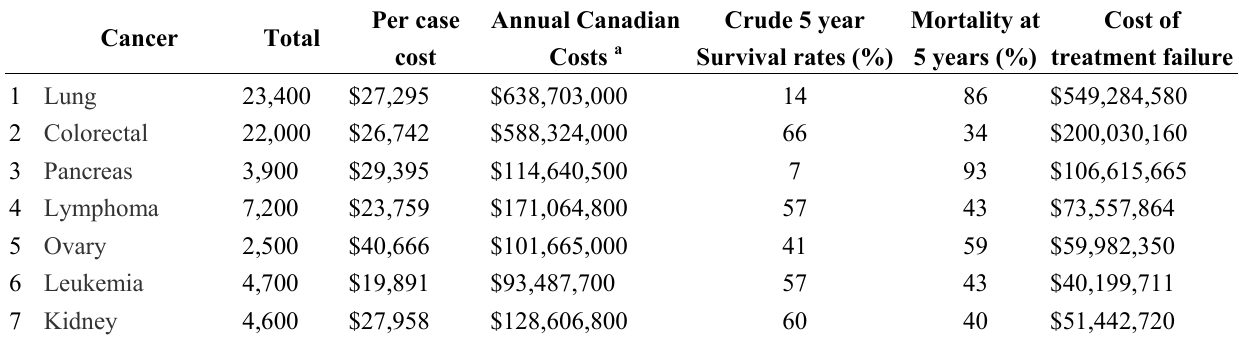
Table 2. Cancer Incidence in Canada in 2009, Ranked by Cost of Treatment Failure (in Canadian dollars) per